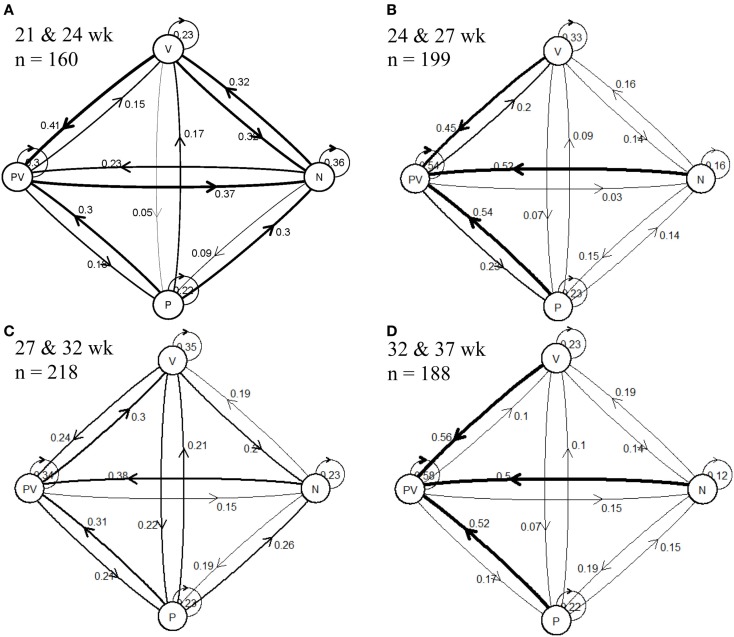
State-transition plot maps for hen pecking categories [feather pecker (P), victim (V), neutral (N), and pecker-victims (PV)] between two consecutive ages at (A) 21 and 24 weeks, (B) 24 and 27 weeks, (C) 27 and 32 weeks, and (D) 32 and 37 weeks. The numbers represent the proportion of the population that performed the transition indicated by the direction arrows.